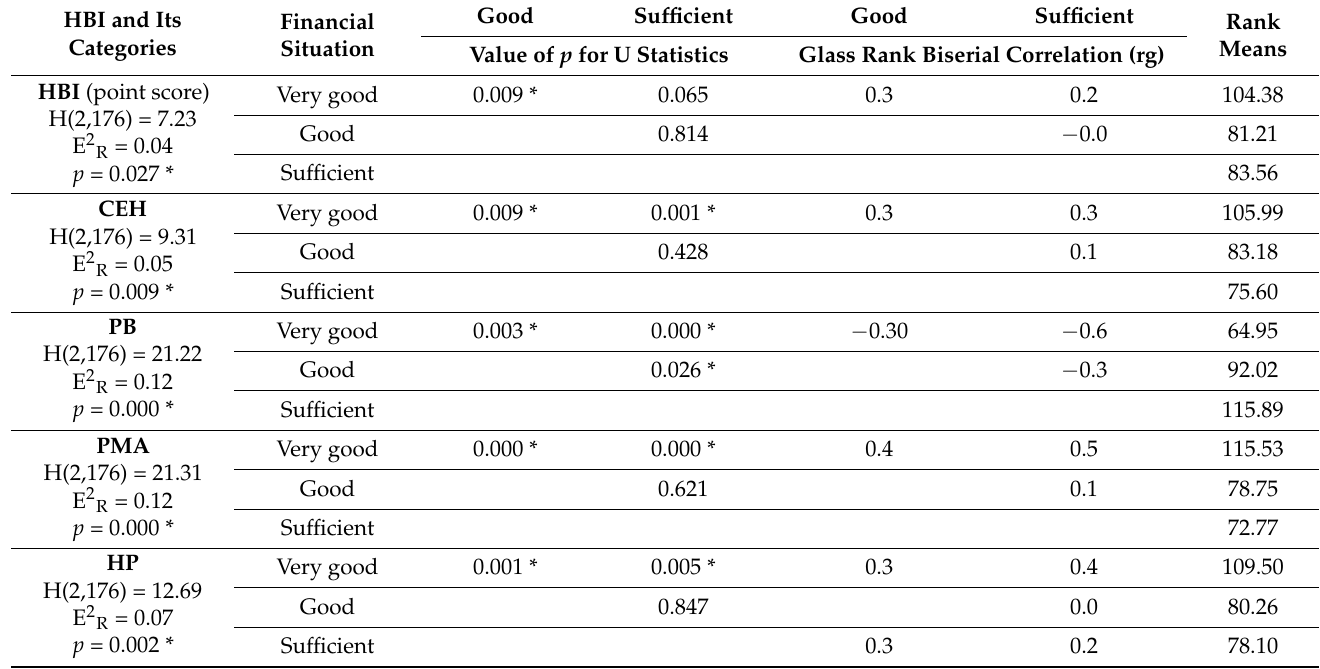
Table 7. Health behaviors of people practicing wheelchair basketball, wheelchair rugby and para- rowing depending on their financial situation (the H test, E 2 R , the U test, rg).